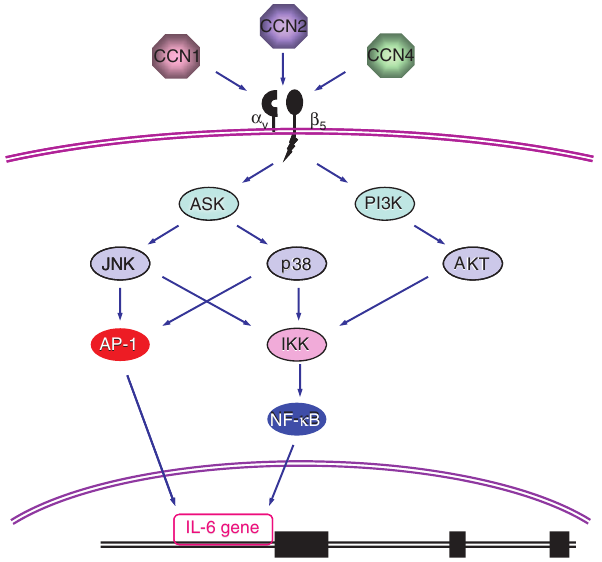
Figure 4 Overview of the signaling for IL-6 induction in inflamed synoviocytes by CCN family